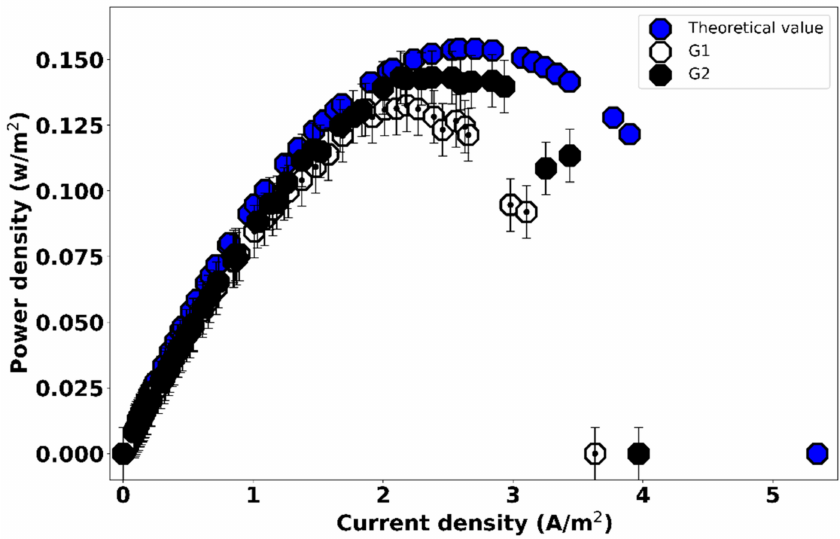
Figure 6. Comparison of P-I curves obtained with spacers G1 and G2 against the theoretical